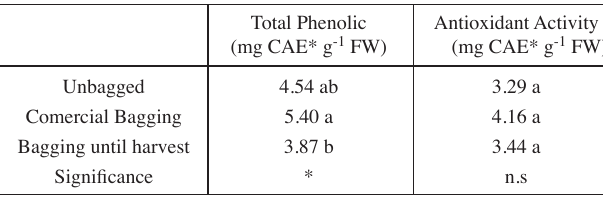
Tab. 7: Effect of bagging in total phenol concentration and antioxidant activity in cv. Fuji